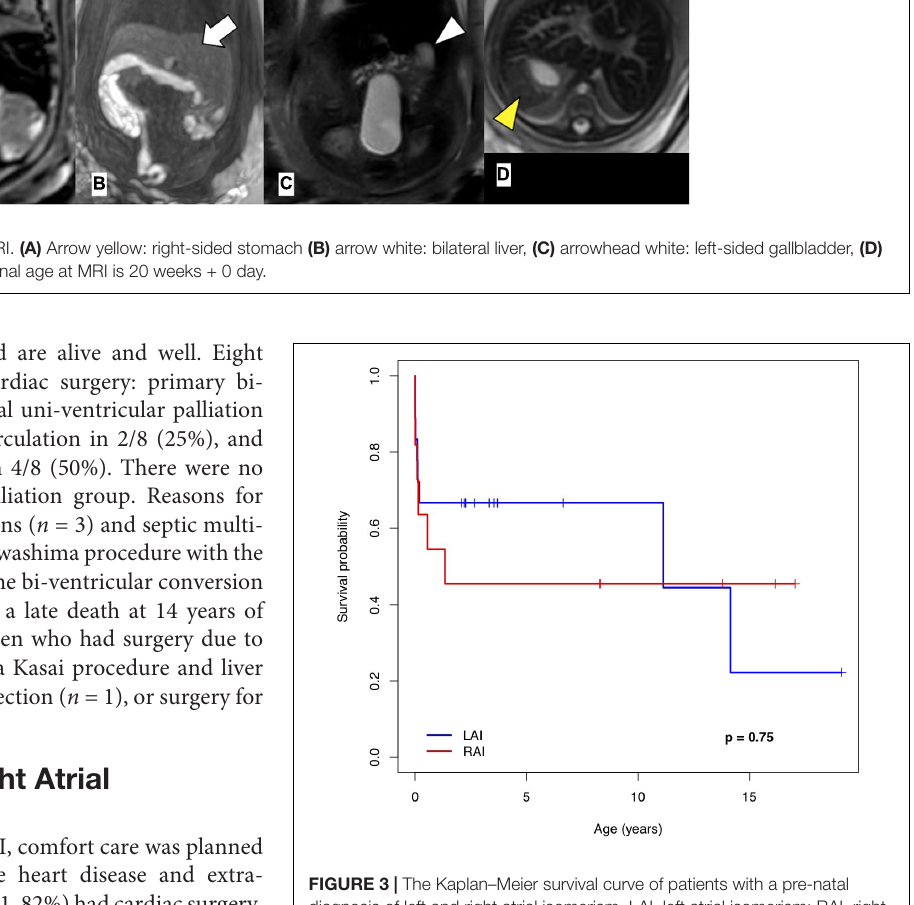
FIGURE 3 | The Kaplan–Meier survival curve of patients with a pre-natal diagnosis of left and right atrial isomerism. LAI, left atrial isomerism; RAI, right atrial